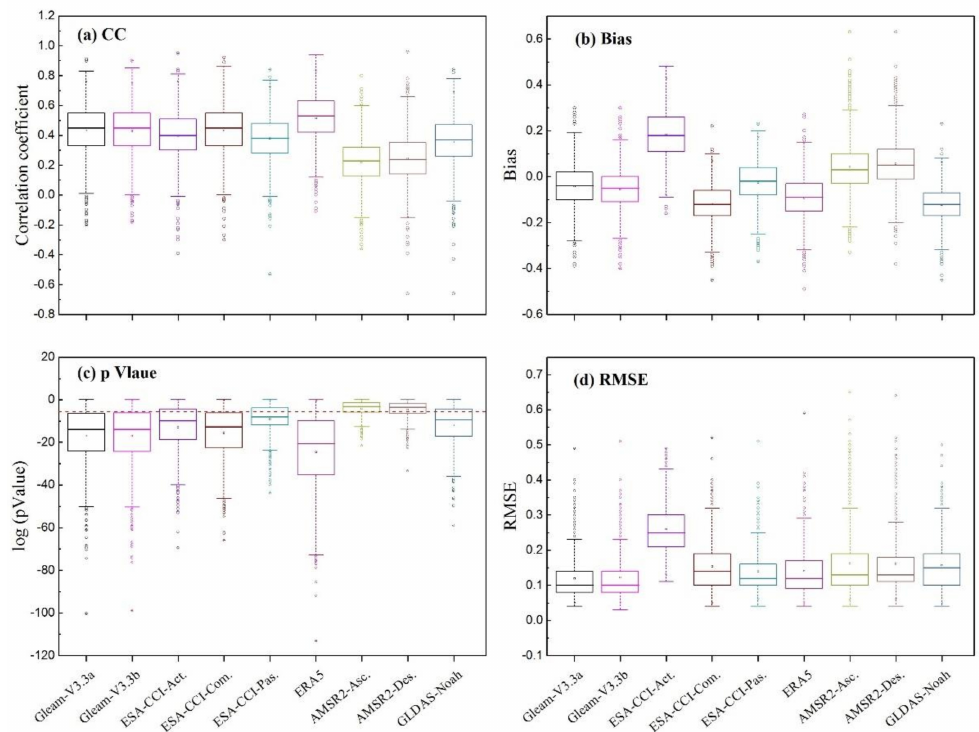
Figure 10. Distribution box diagrams of CC ( a ), bias ( b ), p -value ( c ) and RMSE ( d ) between multi-source SM products and in situ ground observations. Presented are the median, the 1st quantile Q1 and 3rd quantile Q3 (as indicated by the box), and the Q1 − 1.5(Q3 − Q1) and Q3+ 1.5(Q3 − Q1) values (whiskers). (Herein, red short dot line indicates p =